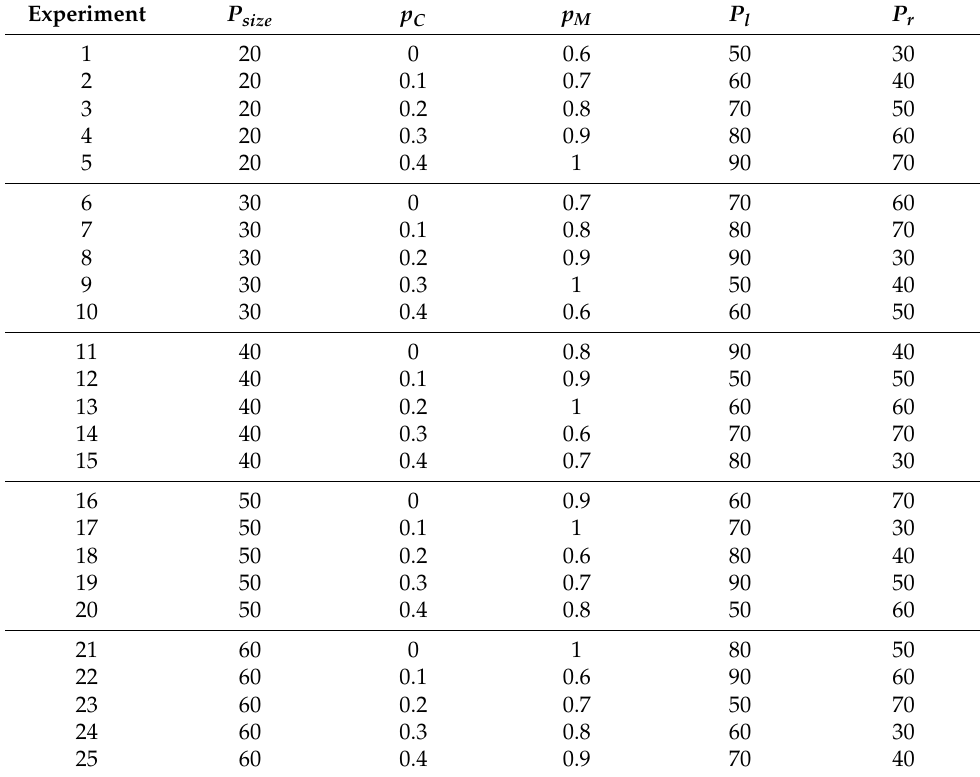
Table 6. Orthogonal array for GA